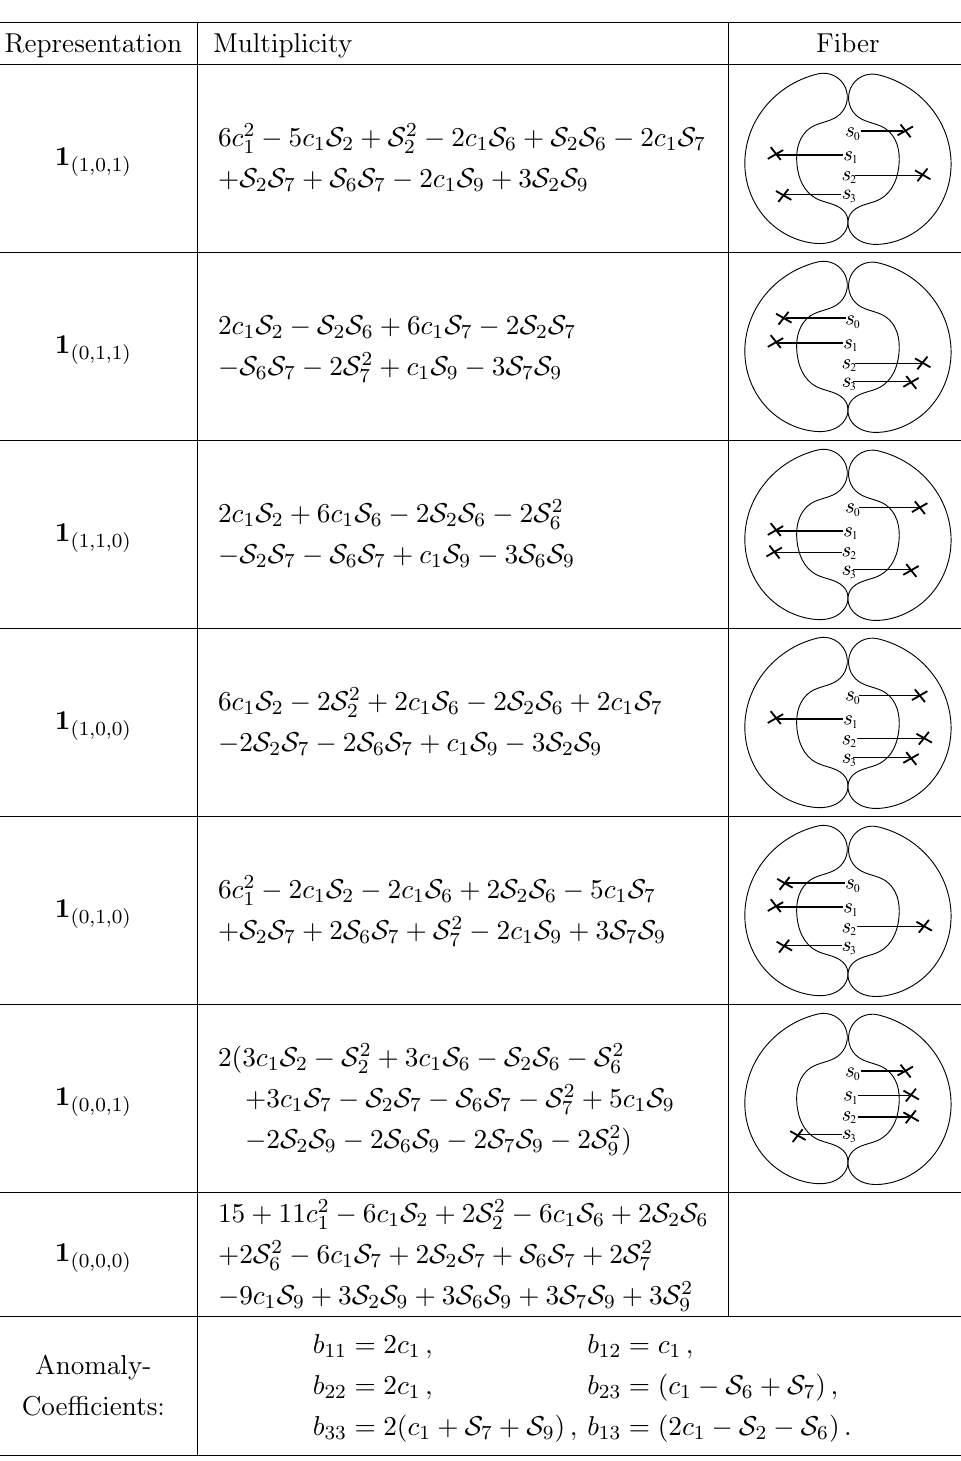
Table 8 . Continuation of table 7 of matter representations and multiplicities from nef (67,0) with G = U(1) 3 . We also depict the intersections of the fiber components with the sections as well as the anomaly